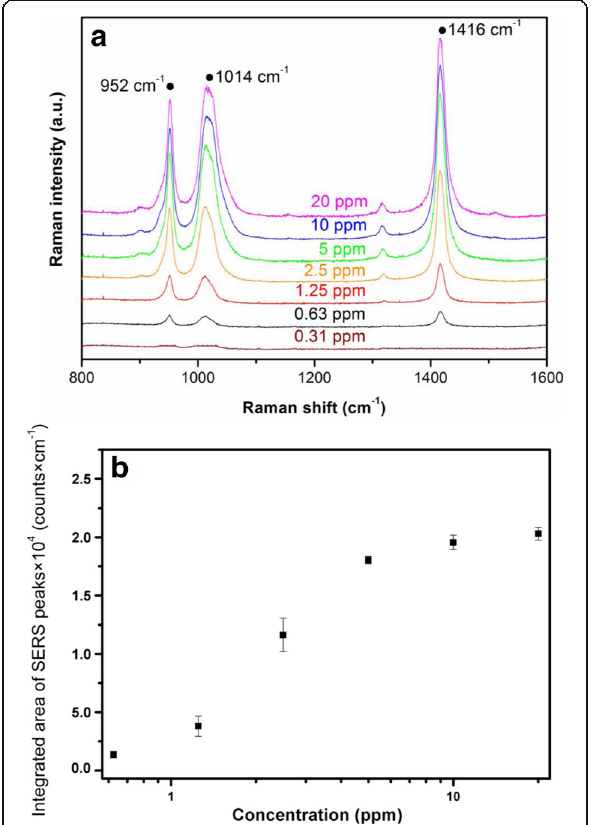
Fig. 7 a SERS spectra of β -carotene at different concentrations